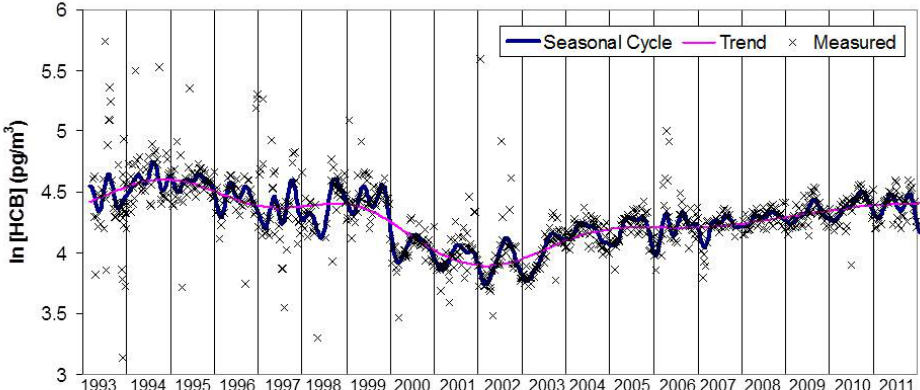
Fig. 8. Temporal trend for hexachlorobenzene (HCB) in air at Zeppelin, Norway during the monitoring period 1993–2012. Data obtained from http://www.nilu.no/projects/ccc/onlinedata/pops/index.html. The trend and seasonal cycles were developed using the Digital Filtration Technique described in detail in Nakazawa et al.